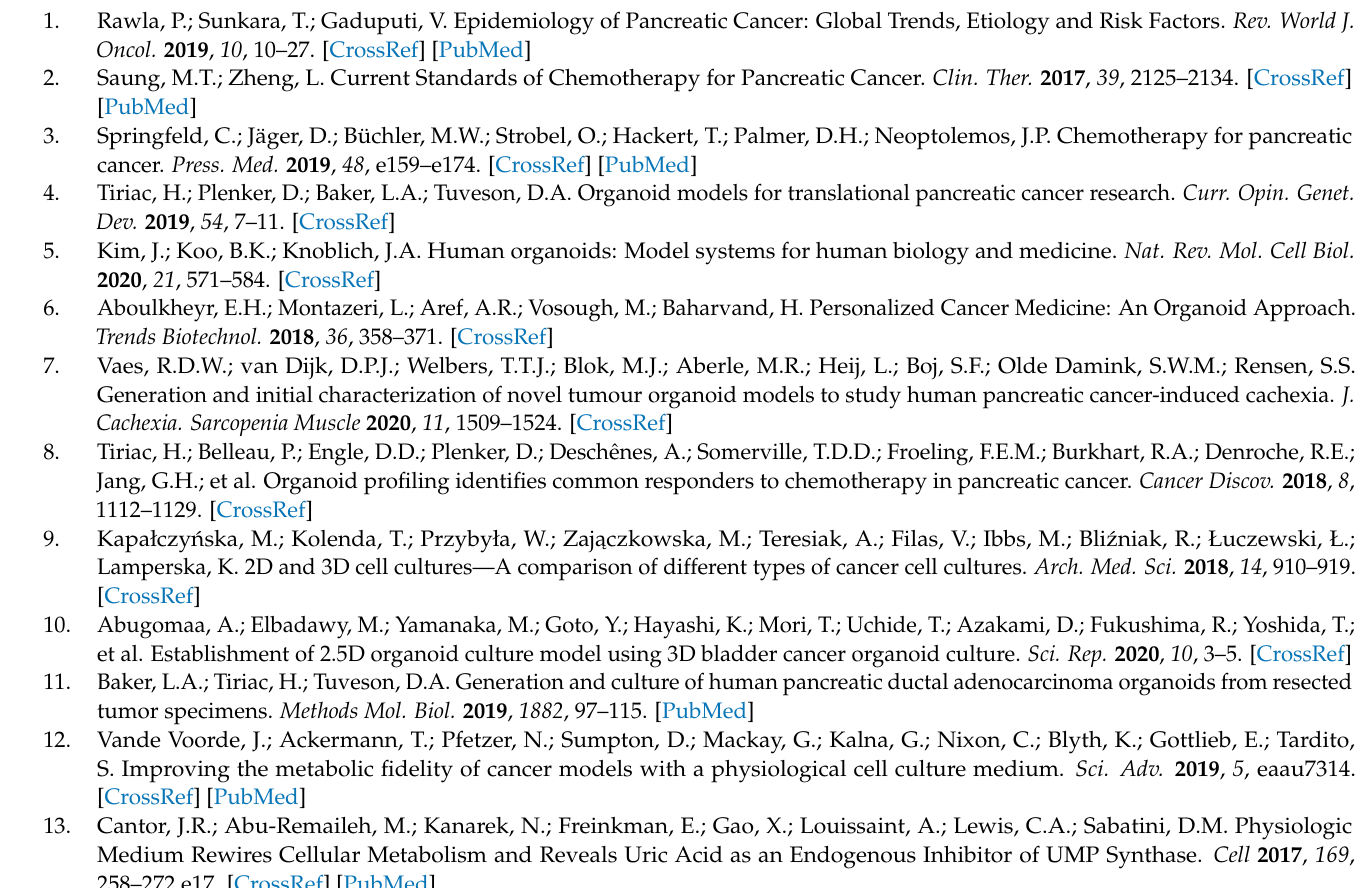
Table S9: IC 50 values of PANCO09b and PANCO11b growing in conventional versus physiological media exposed to gemcitabine, paclitaxel, SN-38, 5-FU, and oxaliplatin; Table S10: GR50 values of PANCO09b and PANCO11b growing in conventional versus physiological media exposed to gemcitabine, paclitaxel, SN-38, 5-FU, and